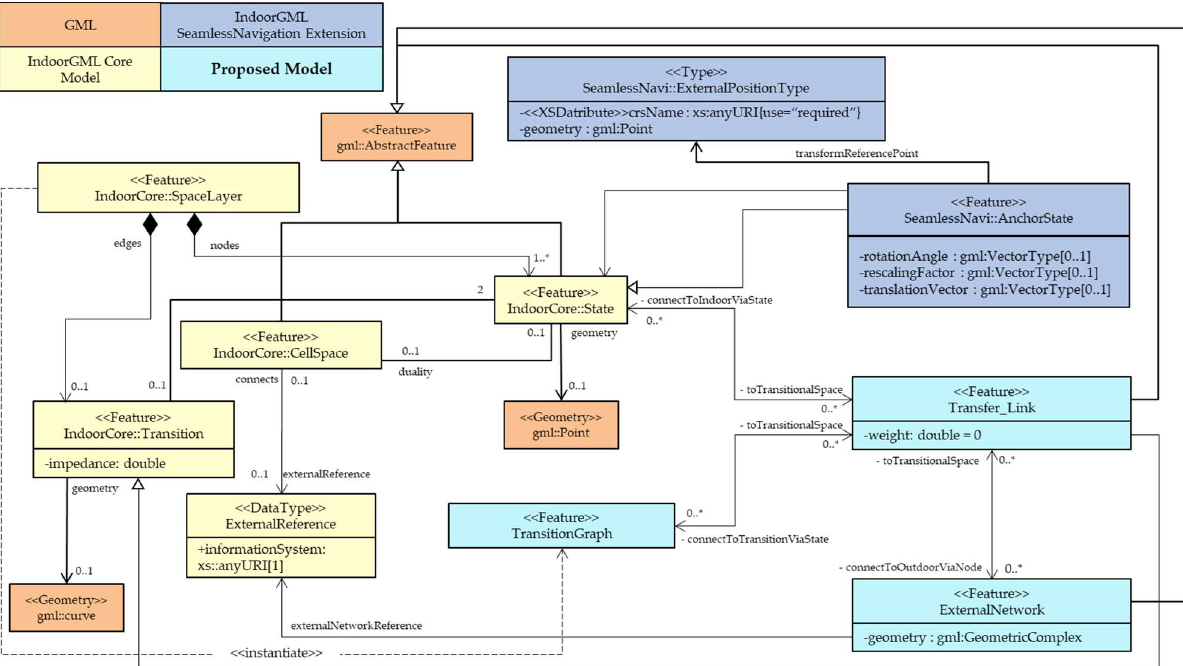
Figure 7. UML class diagram of the proposed data model.